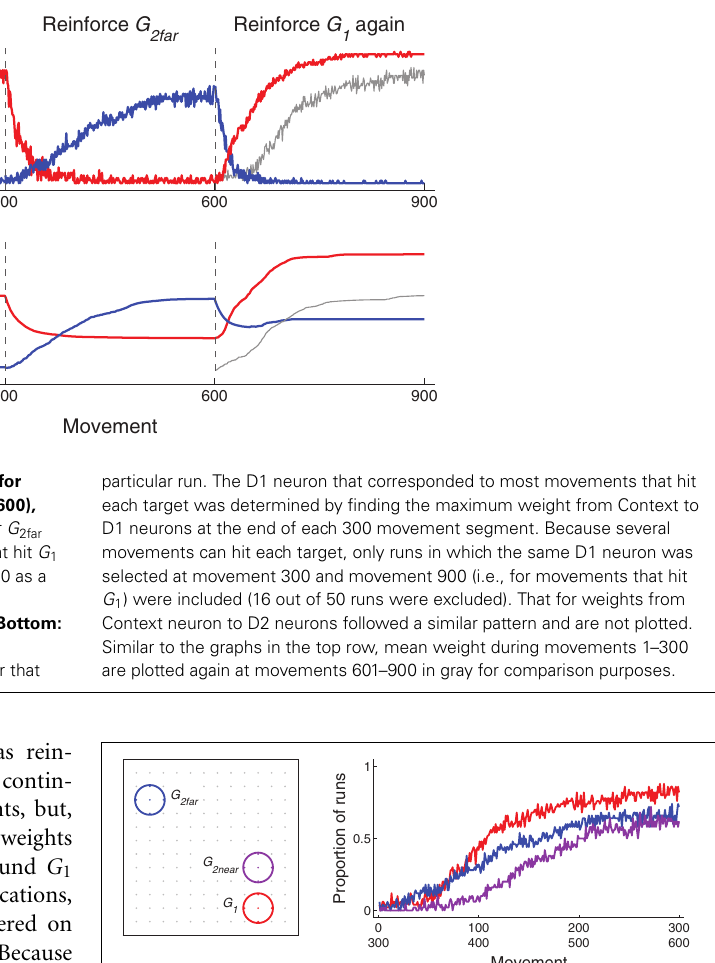
FIGURE 9 | Behavior for Experiment 4: reinforce G 1 (movements 1–300) and then either G 2far or G 2near (301–600). Left: locations of the three targets in the workspace (dots indicate locations corresponding to possible values of G exp , colored gray if those locations do not lie within a target area. Right: proportion of runs that hit G 1 for movements 1–300 or G 2far or G 2near for movements 301–600.